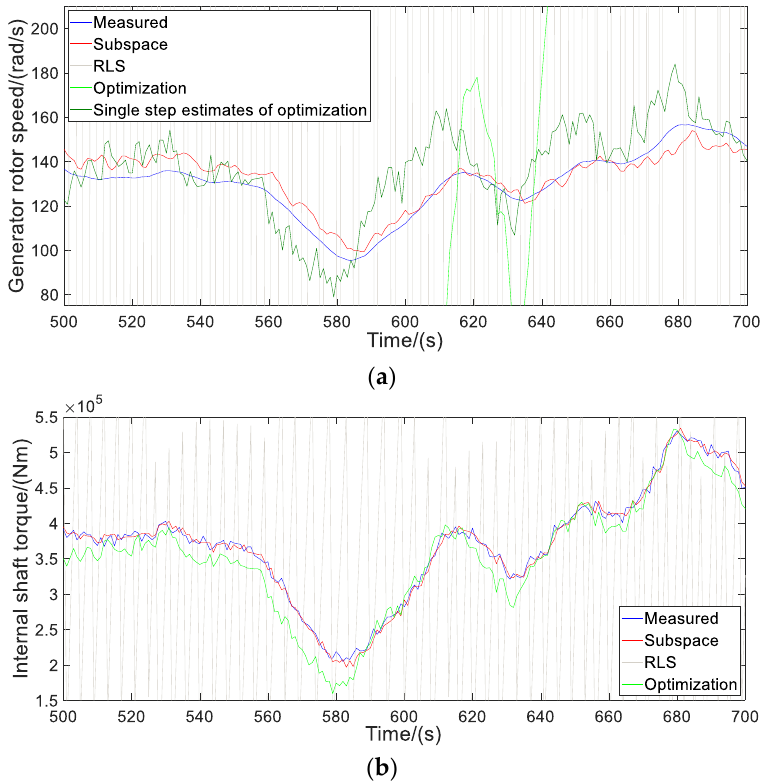
Figure 9. ( a ) Comparison of generator rotor speed under scenario Type 2; ( b ) Comparison of internal shaft torque under scenario Type 2.